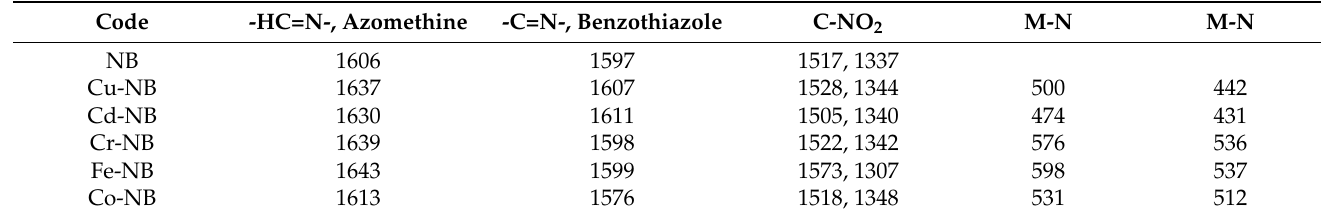
Table 2. FTIR main stretching absorption bands (cm − 1 ) of NB and its metal